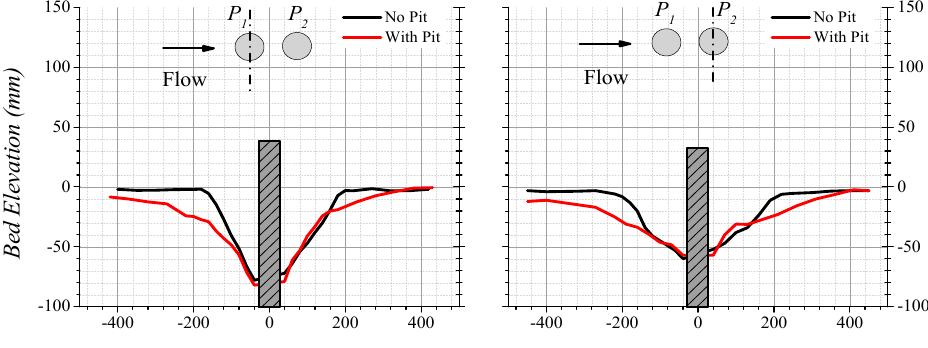
Table 2. Statistics of the morphological features.